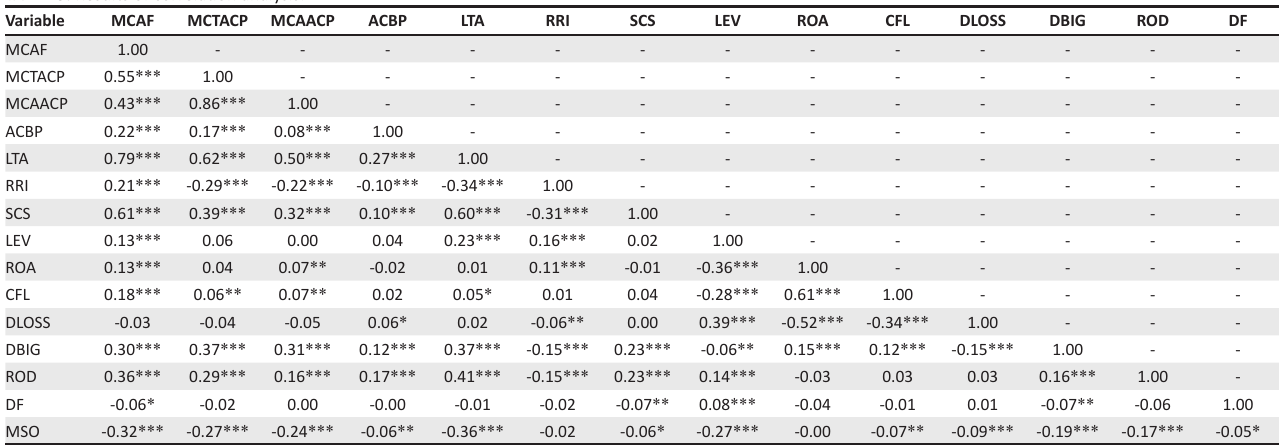
TABLE 3: Results of correlation analysis. Variable